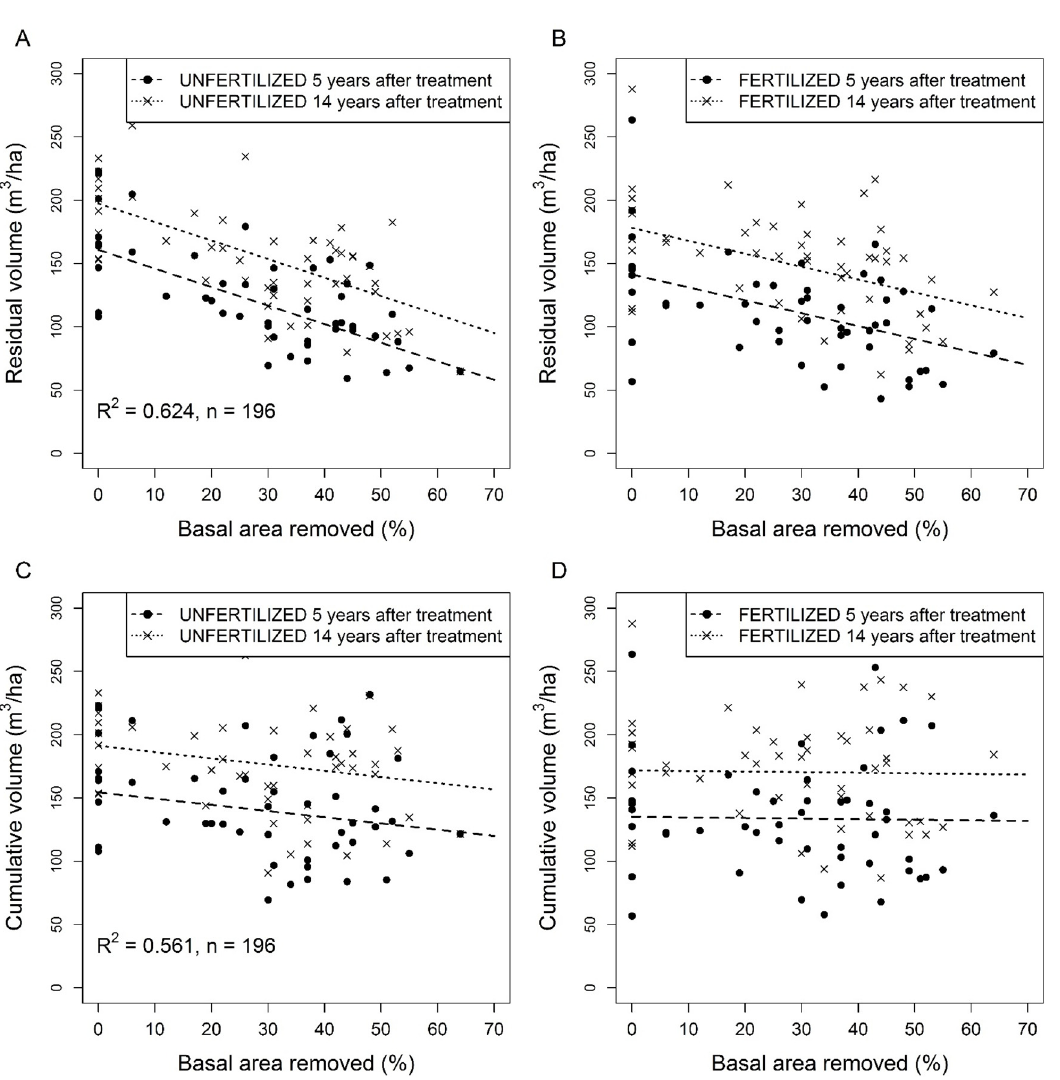
Figure 6. Residual and cumulative (harvested and residual) jack pine stand volume 5 and 14 years after commercial thinning as a function of basal area removed in unfertilized ( A , C ) and fertilized ( B , D ) plots. Untransformed observed (dots) and predicted (lines) values. Cumulative stand volume (harvested and residual) 5 and 14 years after commercial thinning increased significantly with initial stand basal area in both fertilized and unfertilized PSPs (Table 5). However, cumulative stand volume decreased with increasing thinning intensity, and the significant interaction between basal area removed and fertilization showed that cumulative stand volume decreased faster with increasing thinning intensity in unfertilized than fertilized PSPs (Table 5). Fourteen years after thinning, the mean cumulative stand volume was 191 m 3 ha − 1 in unfertilized control PSPs and 156 m 3 ha − 1 in the most intensively thinned (and unfertilized) PSPs (Figure 6C) while mean cumulative stand volume was 172 m 3 ha − 1 in fertilized control PSPs in and 169 m 3 ha − 1 in the most intensively thinned and fertilized PSPs (Figure